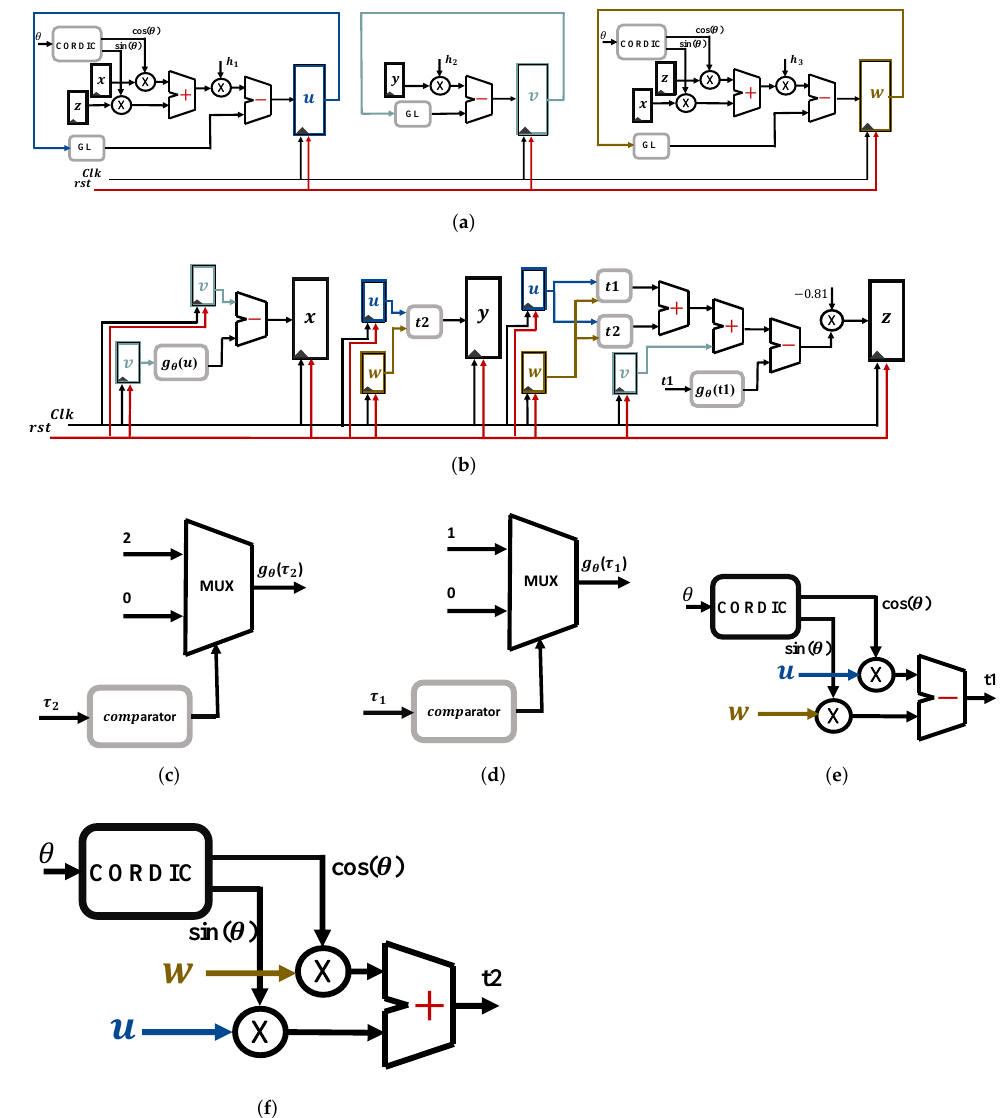
Figure 4. Fractional-order chaotic system 2D rotation: ( a ) fractional-order chaotic system after applying 2D rotation, ( b ) chaotic system, ( c , d ) g ( τ ) architecture, and ( e , f ) t 1 and t 2 architectures.